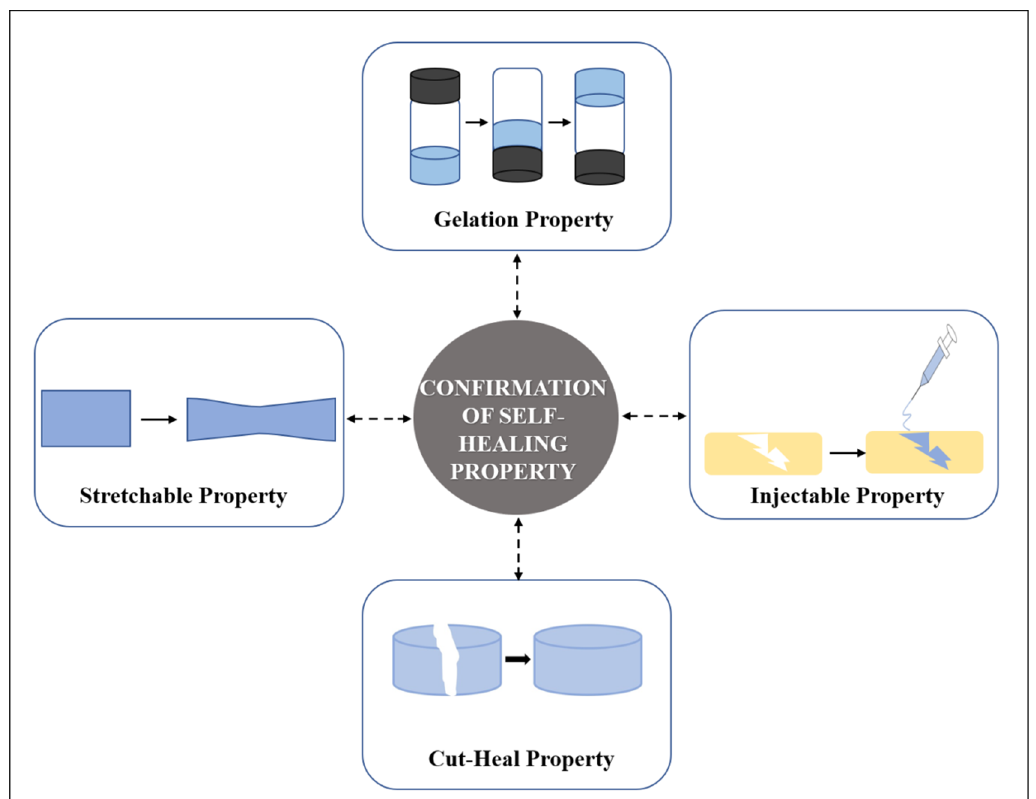
Figure 4. Confirmatory methods of self-healing property of a